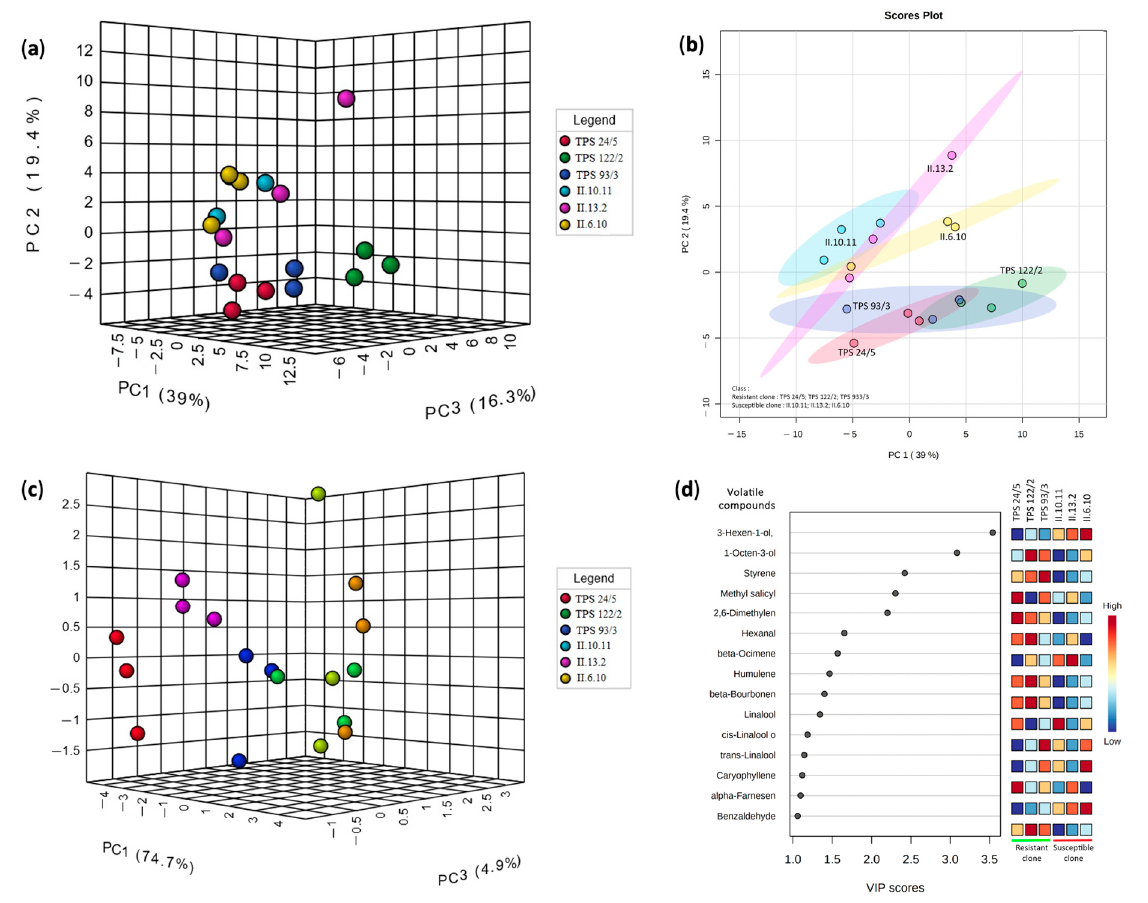
Figure 3. Principal component analysis (PCA) of the volatile compounds that conferred the charac- teristics of resistance and susceptibility of the tea clones to the leafhopper E. flavescens . ( a ) Scree plot PCA; ( b ) Scores plot PCA; ( c ) Scores plot (partial least squares-discriminant analysis (PLS-DA); ( d ) variable importance for the projection (VIP) scores PLS-DA. (PC, principal component).